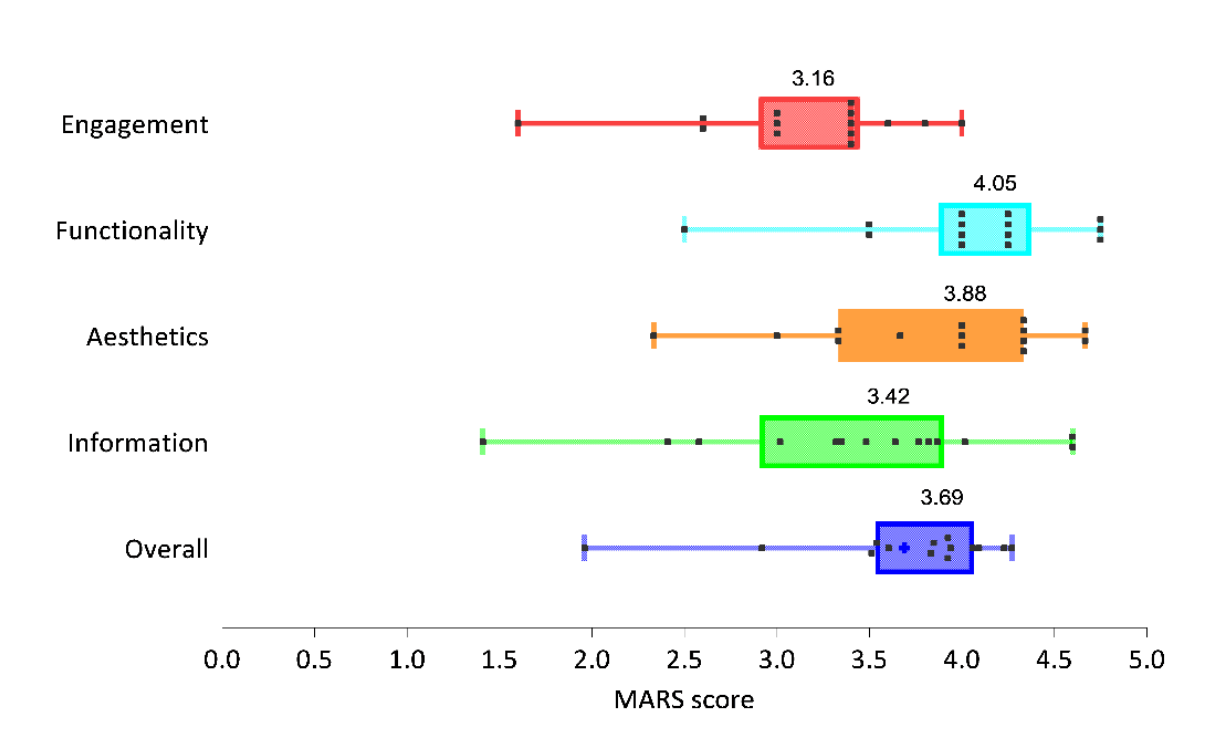
Figure 3. MARS scores by section. The box plot shows the mean, IQR, minimum, and maximum scores. The left and right edge of the boxes represent the first and third quartiles, the line within the boxes represents the mean, and the left and right whiskers represents the minimum and maximum scores. The scatter plot shows the distribution of MARS scores evaluated by 2 raters. MARS: Mobile App Rating